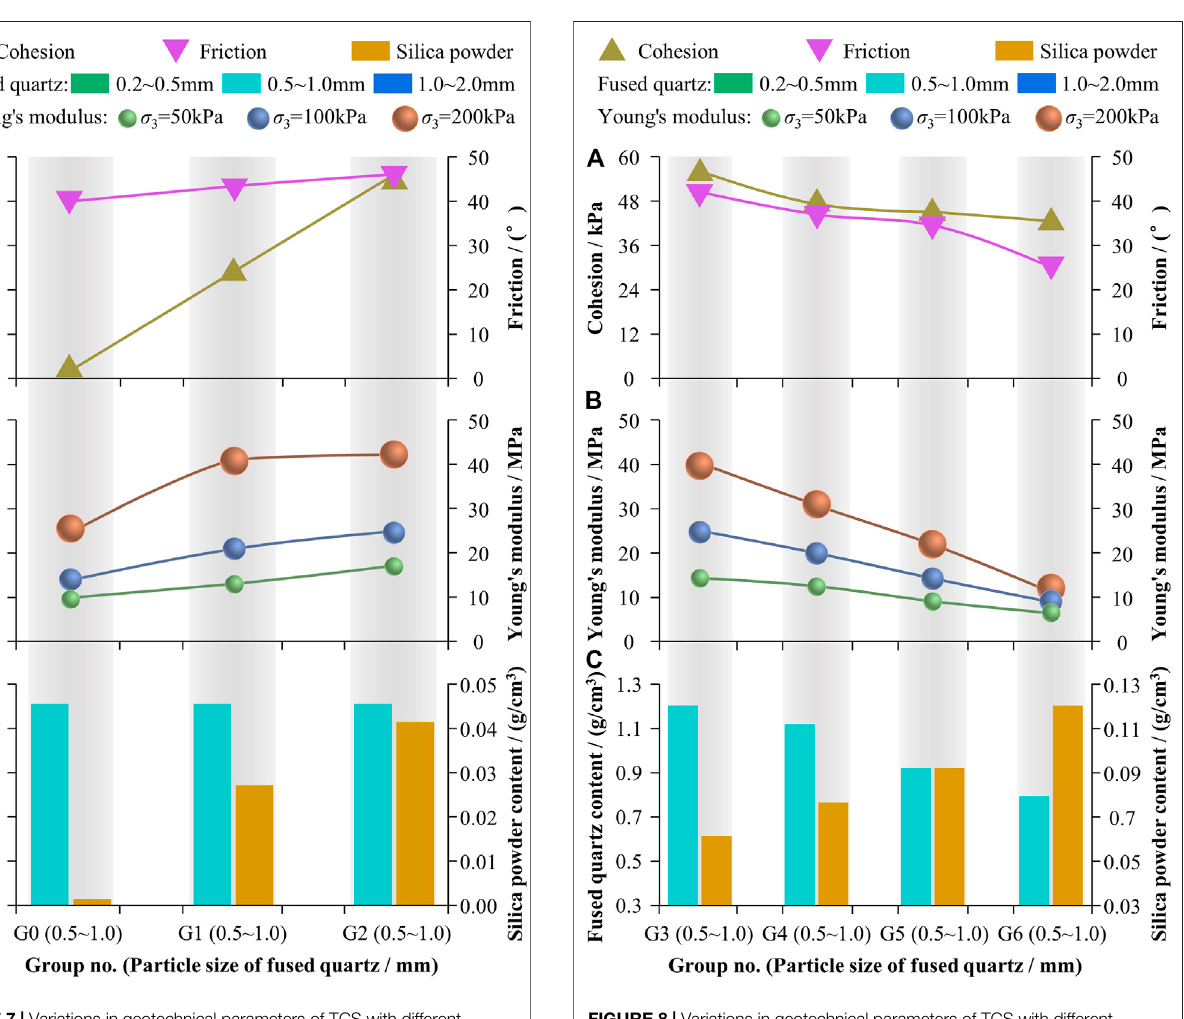
FIGURE 7 | Variations in geotechnical parameters of TCS with different amount of silica powder.